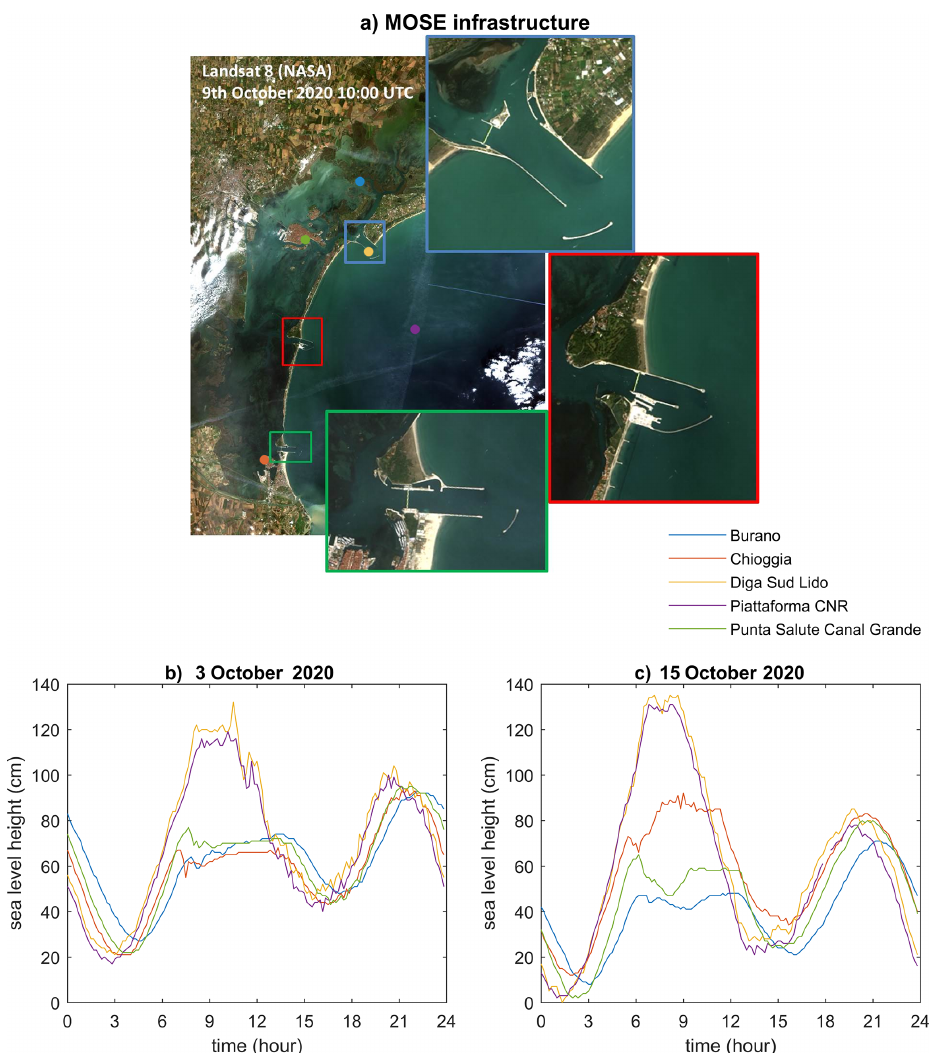
Figure 2. Pre-operational closures of the MoSE in October 2020. (a) Pseudo true colour pan-sharpened Landsat 8 Operational Land Imager (OLI) imagery, acquired on 9 October 2020, showing the Venetian Lagoon inlets during a test closure of the MoSE. The Landsat 8 image is available from the U.S. Geological Survey and was processed by CNR–ISMAR. (b) The water height anomalies measured on 3 October 2020 by tide gauges located within the Venetian Lagoon (Burano, Chioggia, and Punta della Salute – Canal Grande) and in the open Adriatic Sea (Diga Sud Lido and Piattaforma CNR), showing the effect of the MoSE closure on the water height level inside the lagoon. Panel (c) is the same as (b) but for the MoSE closure on 15 October